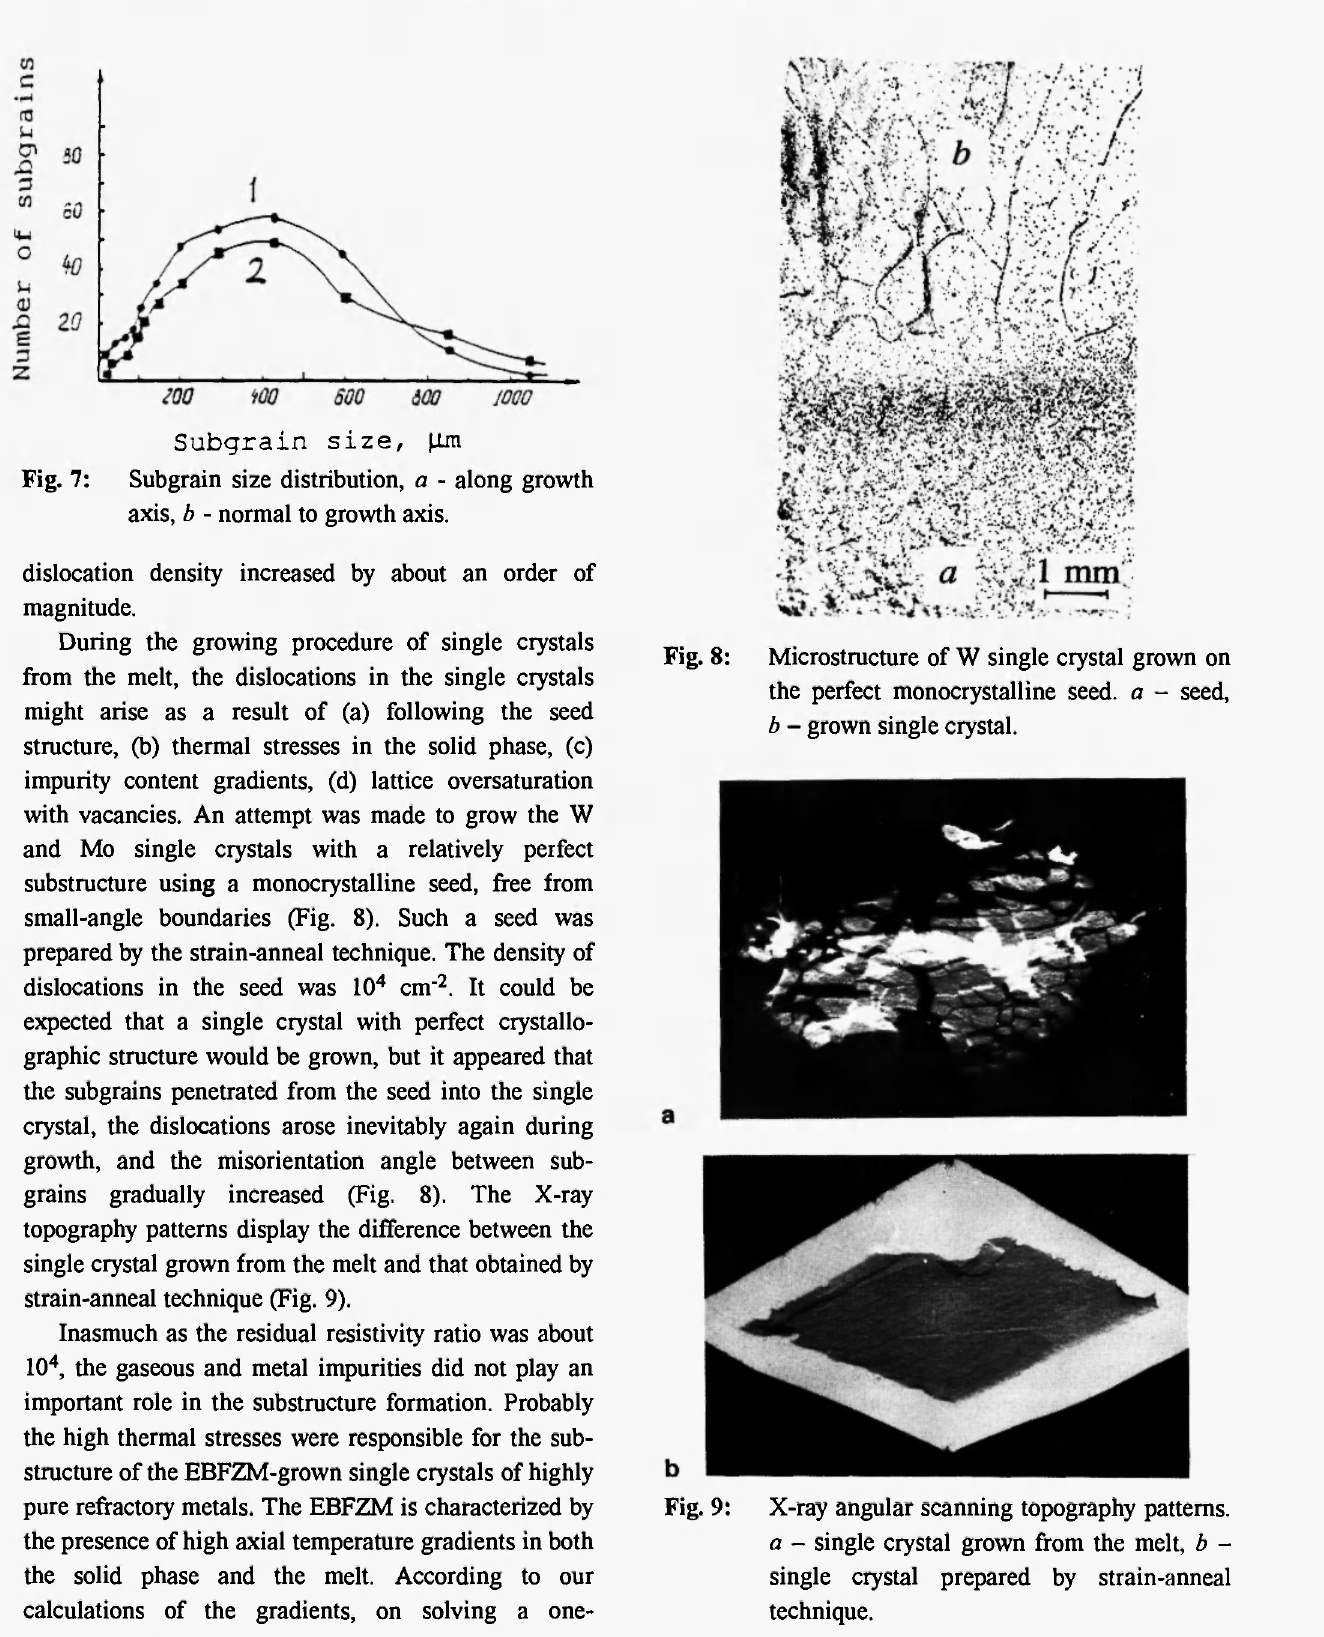
Fig. 9: X-ray angular scanning topography patterns. a - single crystal grown from the melt, b - single crystal prepared by strain-anneal